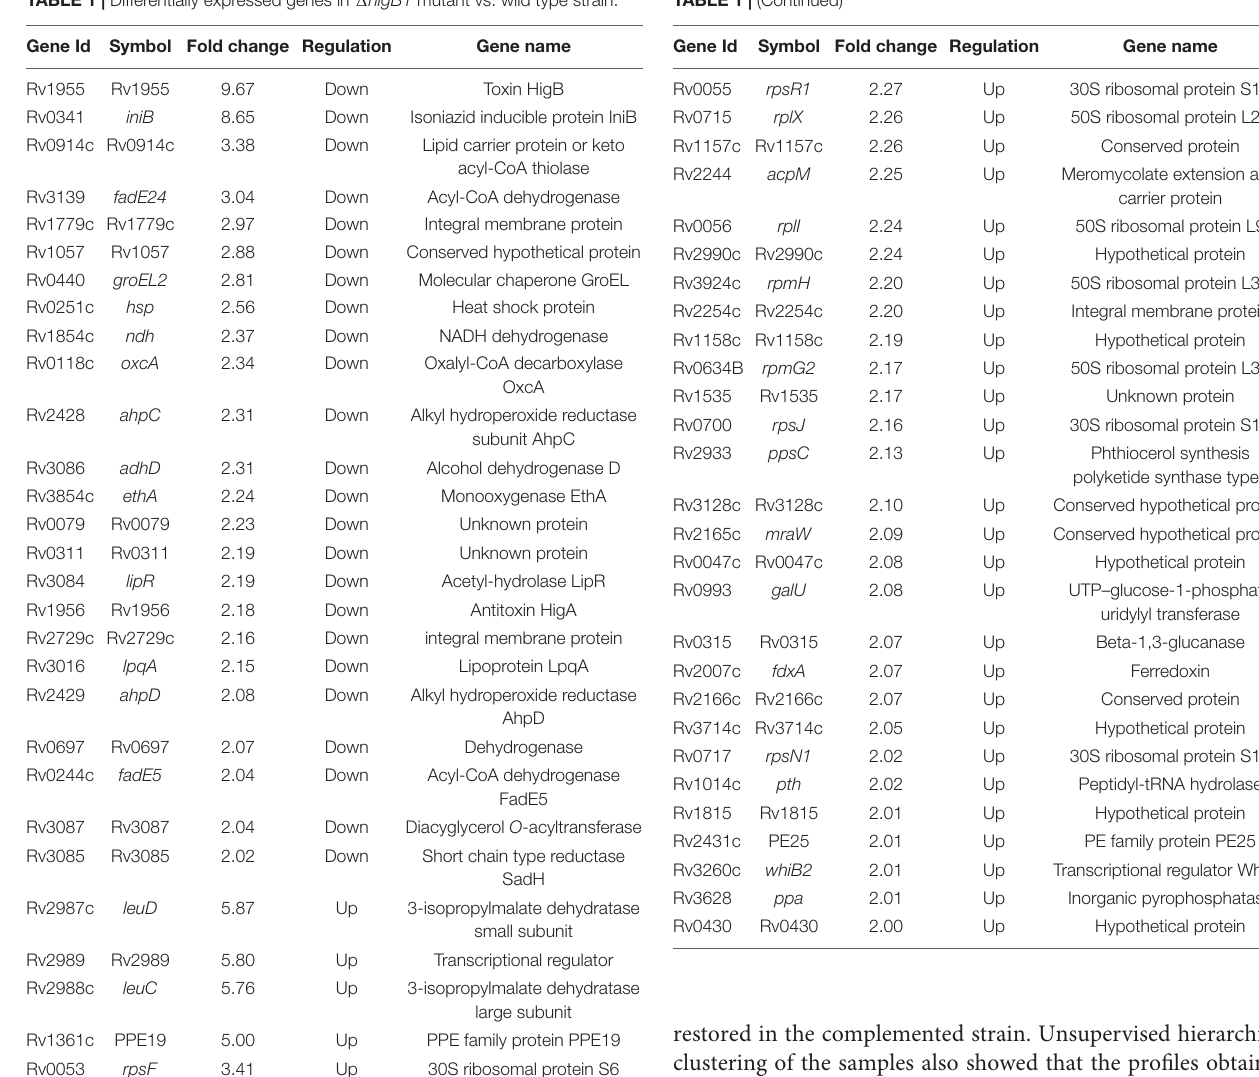
TABLE 1 | Differentially expressed genes in (cid:49) higB1 mutant vs. wild type